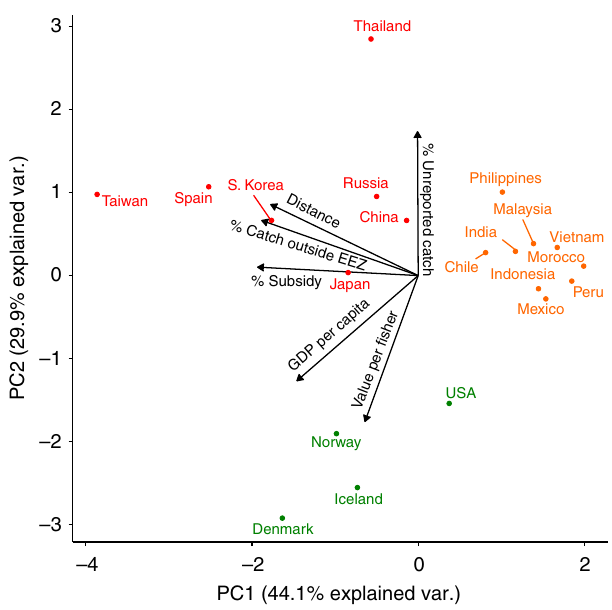
Fig. 2 Biplot of principal components analysis (PCA) for the top 20 industrial fi shing countries. Countries are represented based on their aggregate scores across three economic and three fi shing activity measures. Arrows indicate direction of increasing value for each variable. Colour-coding indicates cluster membership determined by k -means clustering of countries based on their scores on the main PCA